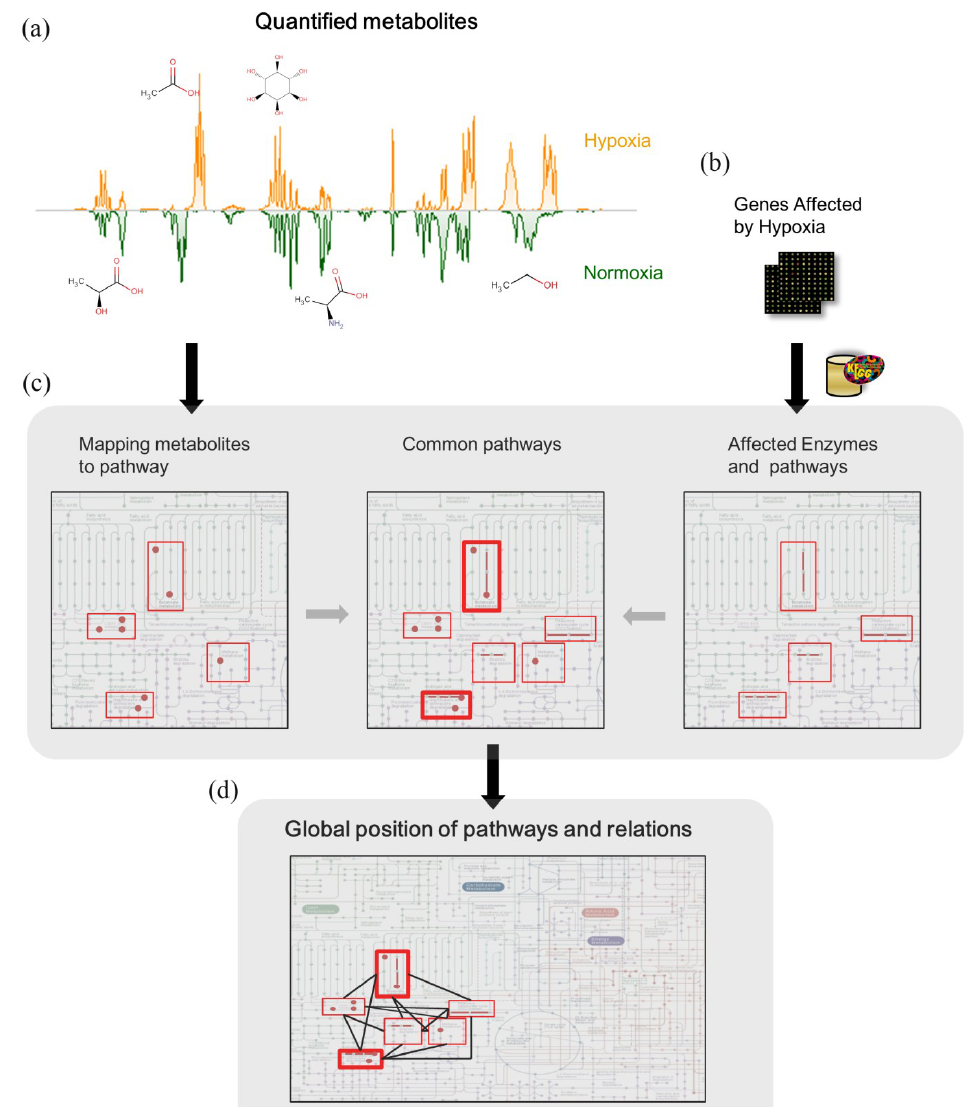
Figure 4. Metabolic network inference from transcriptomic data. ( a ) Quantified metabolites in our metabolomics study. ( b ) Genes affected by hypoxia in breast cancer cell were manually curated from literatures. ( c ) Enzymes corresponding to the genes and pathways affected by the corresponding enzymes were retrieved through KEGG KGML database. The pathways inferred from genomic data and quantified metabolites in our NMR spectra were listed and compared (Table 2). ( d ) To see the relations between pathways, pathways were further mapped to the KEGG global map, the complete result was shown in Figure